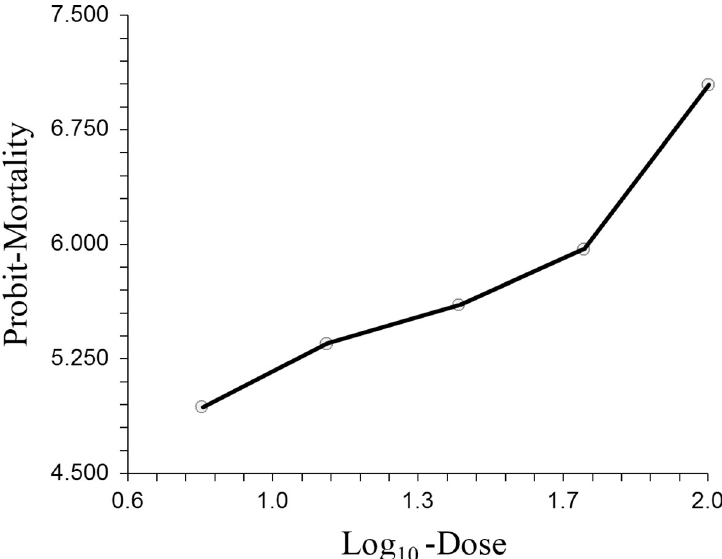
Fig 3. Probit mortality of Lobesia vanillana larvae, 48 h after treatment. Treatments were applied in logarithmically calculated dosages of 100, 50, 25, 12, 6 and 0 IJs/larva, using infective juveniles of in vitro -cultured Steinernema yirgalemense .